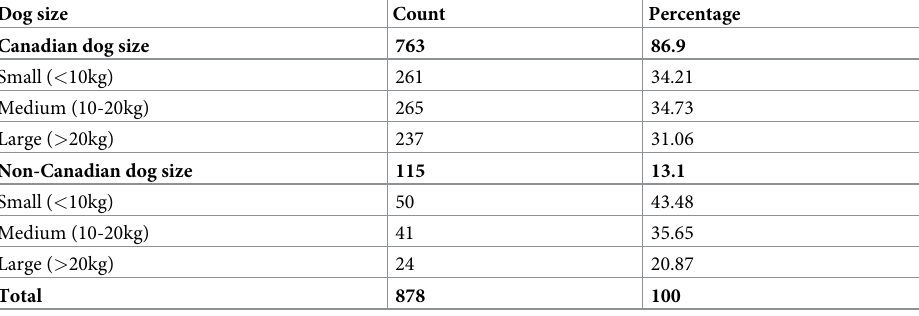
Table 15. Canadian and non-Canadian dog sizes. Dog size Count